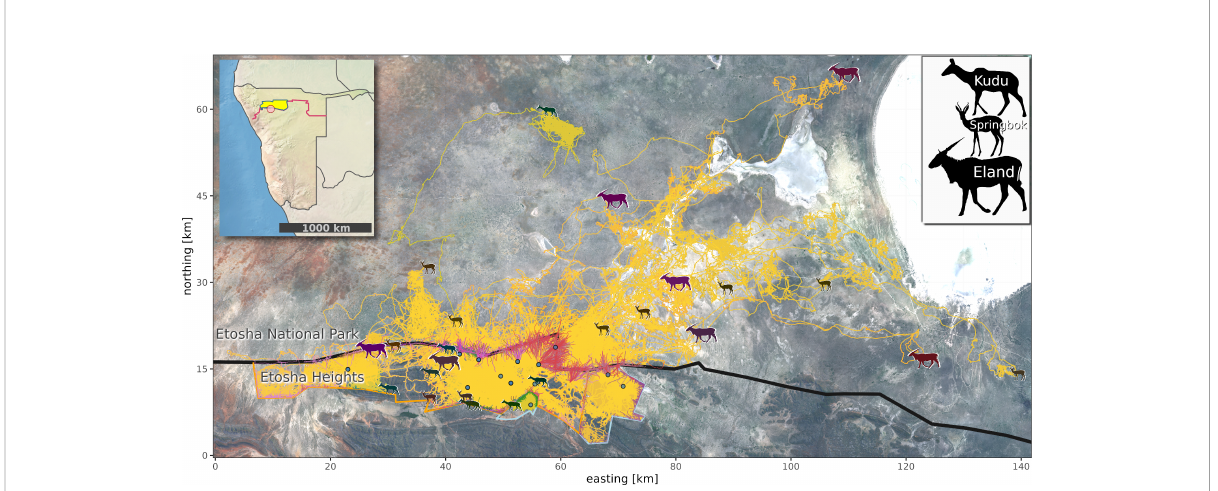
FIGURE 1 Study area with fence lines (black line — veterinary cordon fence, orange line — electri fi ed fence, blue lines — wildlife-proof fences), movement trajectories (in yellow), and sub-trajectories 45 min before, during, and after fence interactions (colored lines). Species symbols (see legend) depict the farthest position of an individual from its most frequently visited water site (blue points). Background Sentinel 2 (Bands 3,4,5) image, March 2020 (contains modi fi ed Copernicus Sentinel data [2020]). Upper left Namibia map shows the veterinary cordon fence (VCF, red line) and focal wildlife conservation areas (yellow area — Etosha National Park, red point — Etosha